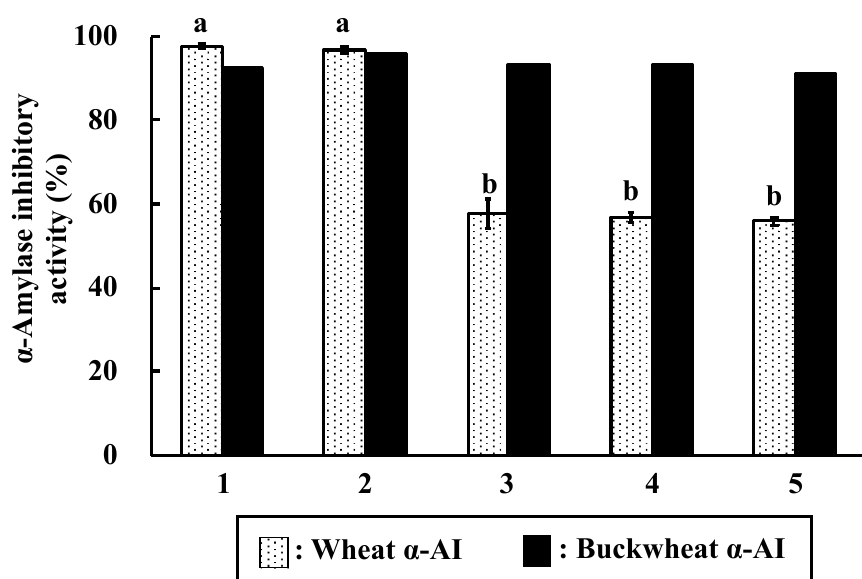
Figure 7. α -Amylase inhibitory activity of wheat and buckwheat α -AIs after digestion. (1) Undigested; (2) Digested by pepsin for 2 h; (3) Digested by pepsin for 2 h followed by digestion with trypsin for 2 h; (4) Digested by pepsin for 2 h followed by digestion with trypsin for 4 h; and, (5) Digested by pepsin for 2 h followed by digestion with trypsin for 6 h. Values with different letters are significantly different at p < 0.05.